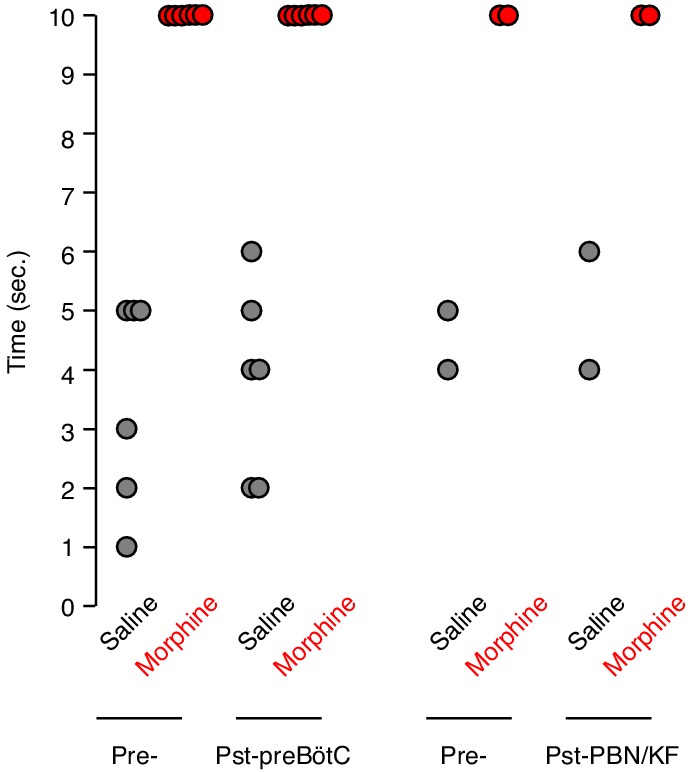
Tail flick response before and after bilateral preBötC or PBN/KF injection.The tail flick response time was measured 15 min after IP saline (gray) or 20 mg/kg morphine (red) injection. Each animal was assayed twice before (Pre-) and twice after (Pst-) bilateral AAV-Cre-GFP injection into either the preBötC or PBN/KF of adult Oprm1f/f mice. Dot, time for single assay of one animal. Note, Oprm1 in the preBötC and PBN/KF is not required for morphine’s ability to blunt the tail flick response.